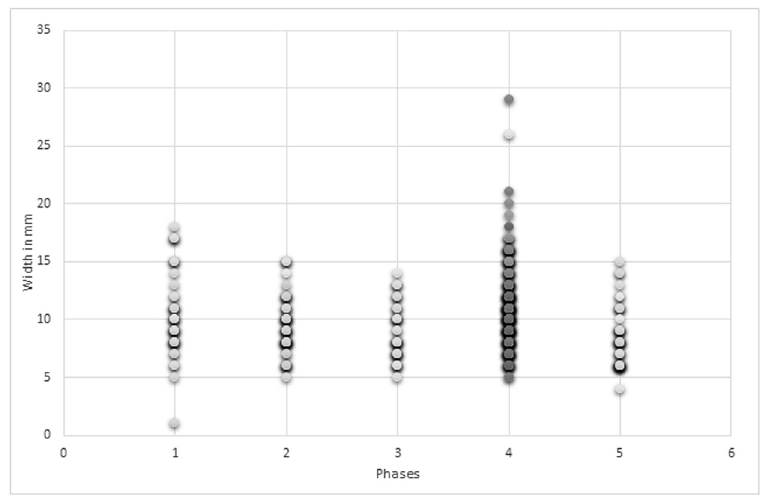
Figure 4: Graph of width ( obsidian laminar supports ) per separate phases: Bande Rosse ( 1 ) , Tricromiche ( 2 ) , Serra d ’ alto ( 3 ) , Diana ( 4 ) , and Spatarella ( 5 )